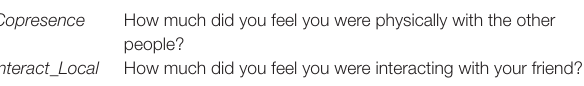
TaBle 3 | Questions related to the local participant experience.